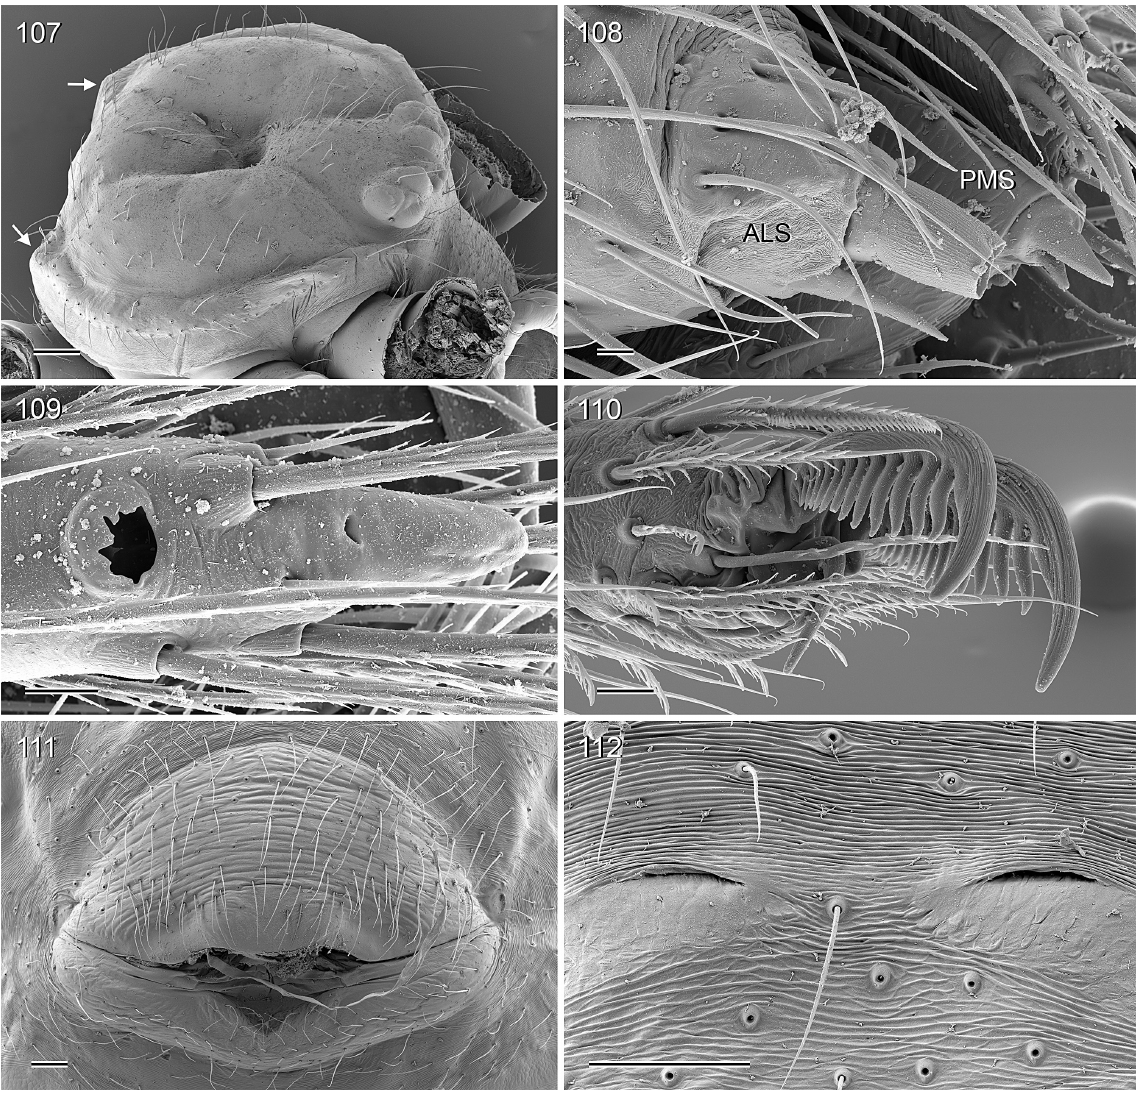
Figs 107–112. Stygopholcus montenegrinus Kratochvíl, 1940; male and female from Studenačka pećina, Montenegro (ZFMK (Ar 22201)). 107 . Female prosoma; arrows point at humps opposing modified areas on abdomen. 108 . Female anterior lateral spinneret (ALS) and posterior median spinneret (PMS). 109 . Tip of female palp, dorsal view. 110 . Tip of female tarsus 1. 111 . Epigynum, ventral view. 112 . Indentations (muscle attachment sites) between epigynum and spinnerets. Scale bars: 107 = 200 µm; 108 = 10 µm; 109–110 = 20 µm; 111–112 = 100